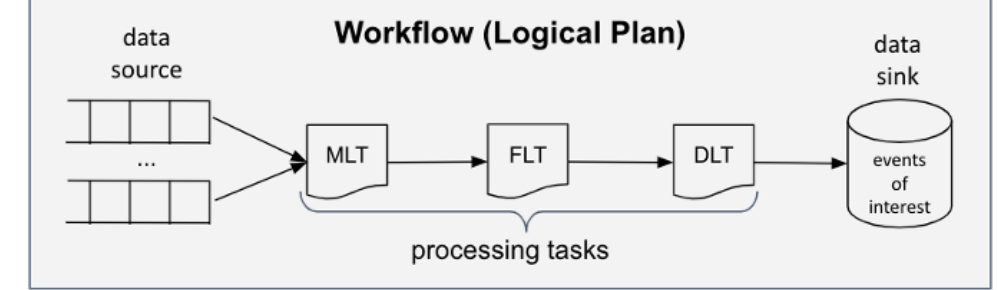
Figure 4. Application’s